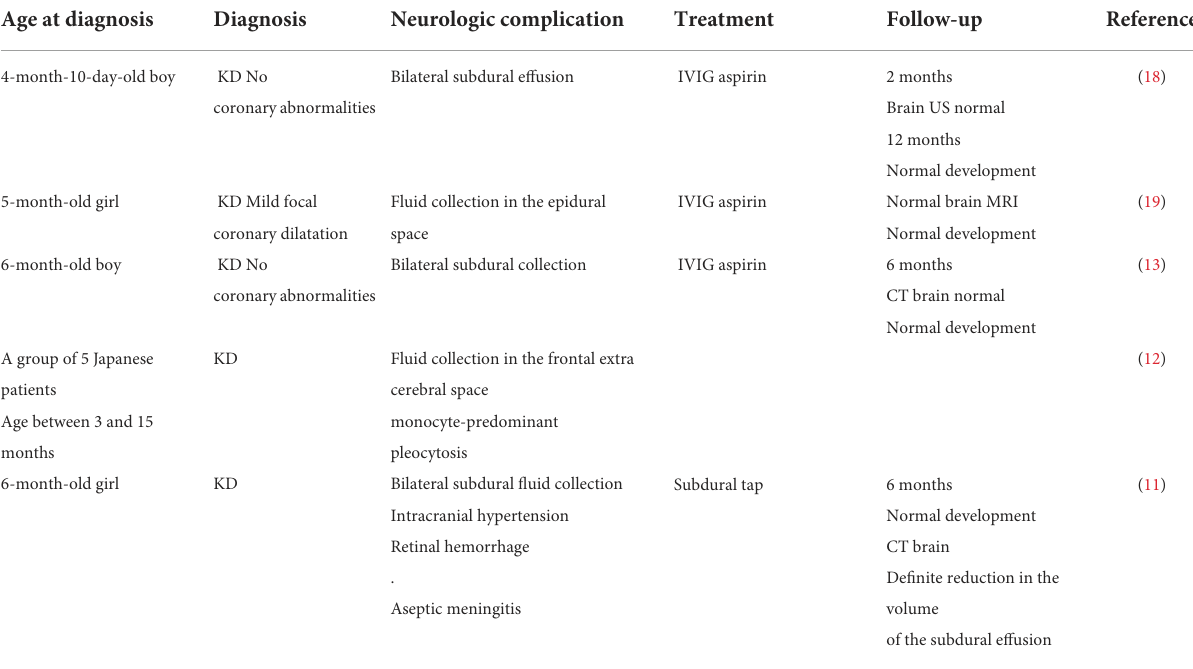
TABLE 1 Clinical presentations of patients who had subdural collection associated with Kawasaki